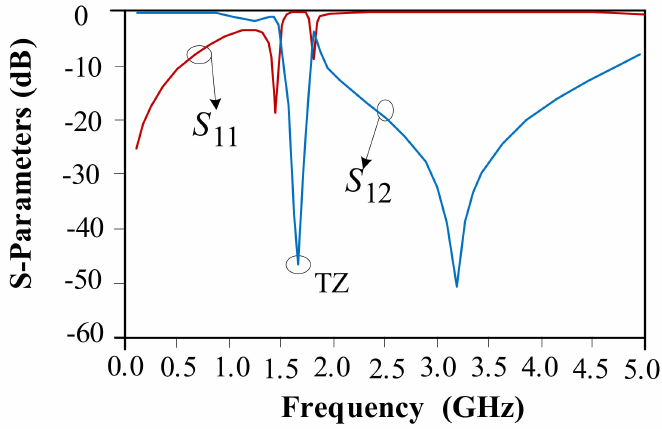
Figure 11. EM simulation response of the proposed horizontal